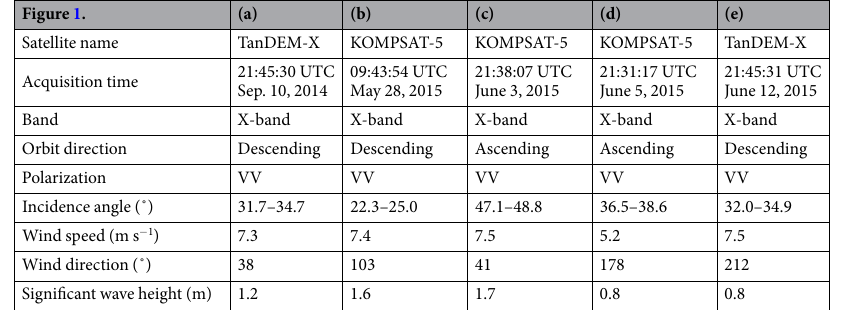
Table 2. Specification of SAR images with sea surface wind and wave conditions.